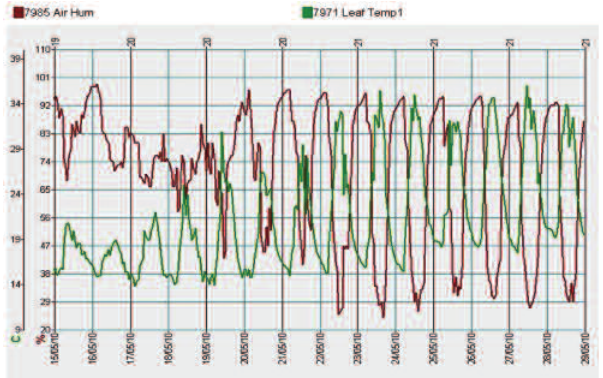
Figure 3. Rose leaf temperature in relation with the air humidity